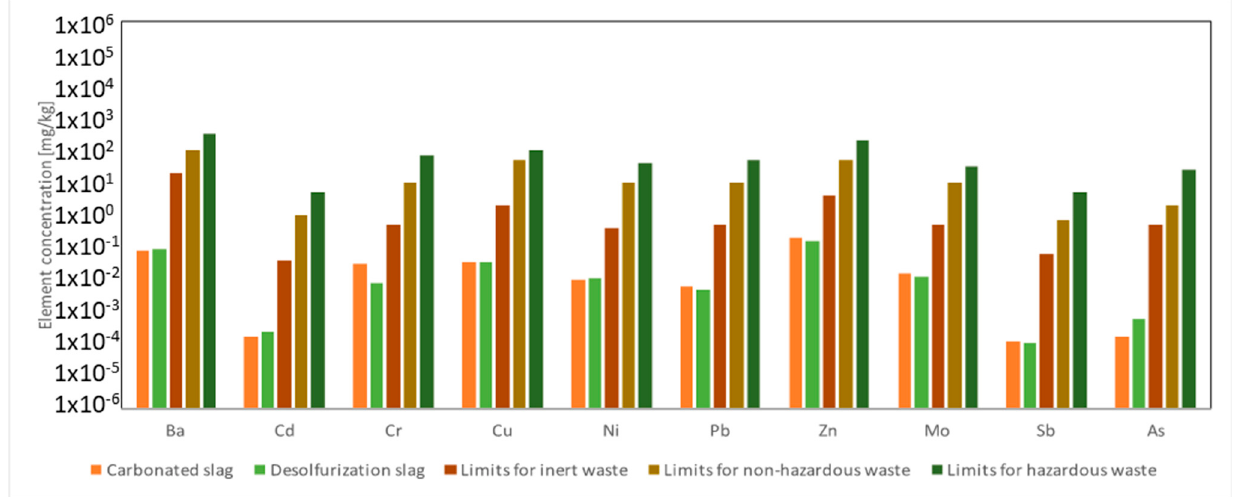
Figure 4. Heavy metals (mg/L) in the slags carbonated and desulfurization eluates after leaching test in water (EN 12457-2) and comparison with the limits defined in 2003/33/EC for inert, non-hazardous and hazardous wastes (due to variability of the raw materials and the analytical process, the error associated with the measure is 30%).